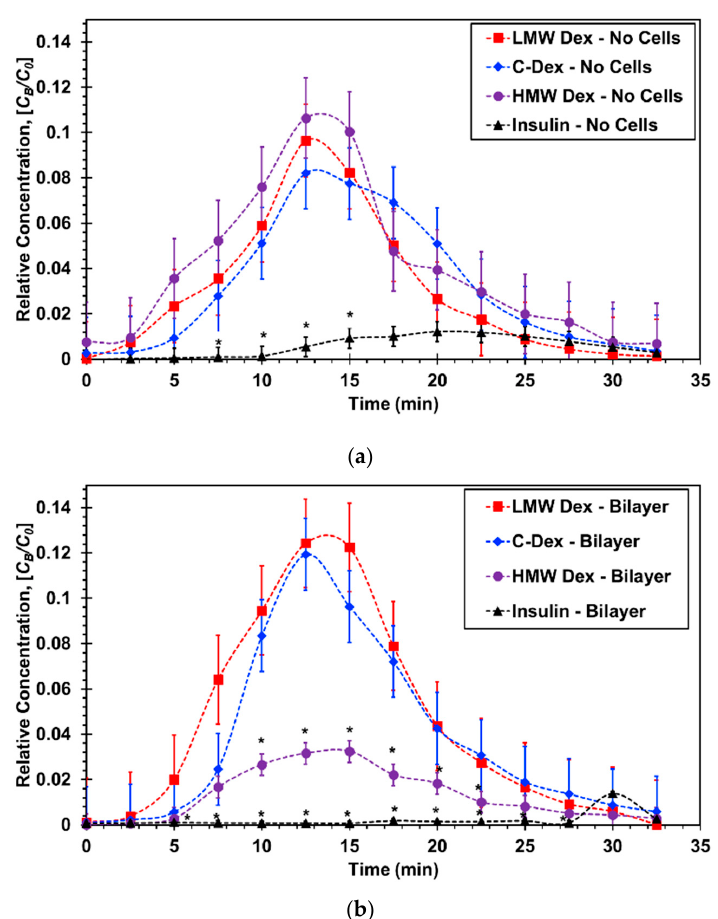
Figure 6. Concentration–time curves for microfluidic bilayer devices: ( a ) Without cells and ( b ) with an epithelial/endothelial barriers. * p < 0.05 compared with LMW Dextran.